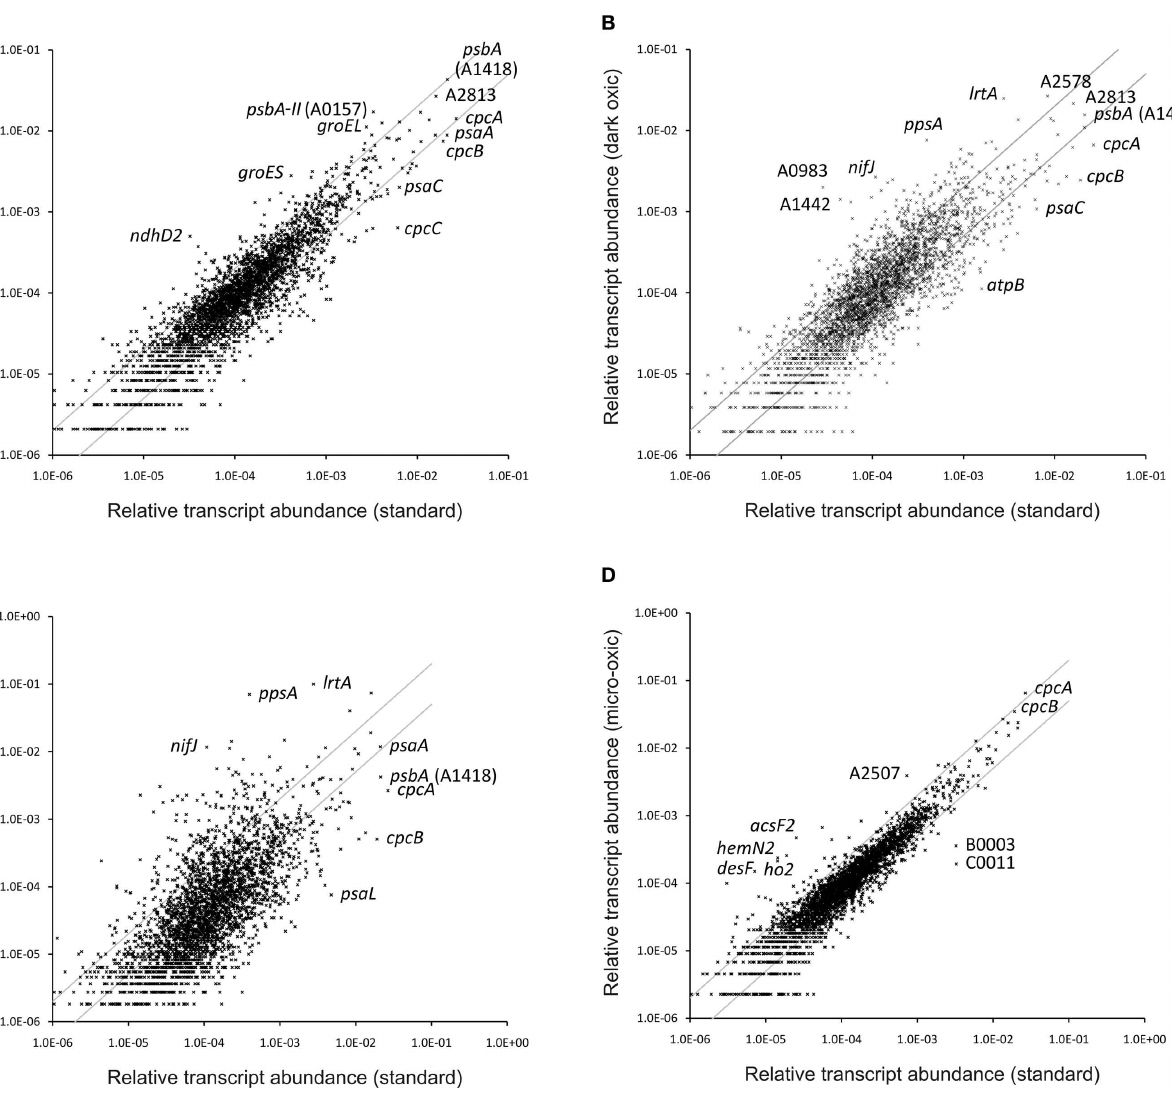
biological replicates). Scatter plot (D) shows the relative transcript abundances for a culture grown under micro-oxic conditions compared to a culture grown under “standard conditions”. The gray lines give two-fold changes in either direction. Selected genes are identified by name/locus tag